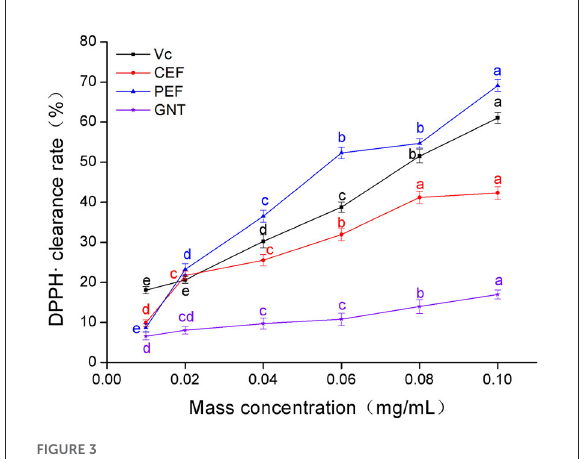
FIGURE3 DPPH · clearance rate of CEF, PEF, and GNT at different concentrations. Different letters indicate significant differences in DPPH · scavenging ability of the same substance at different concentrations ( p < 0.05).